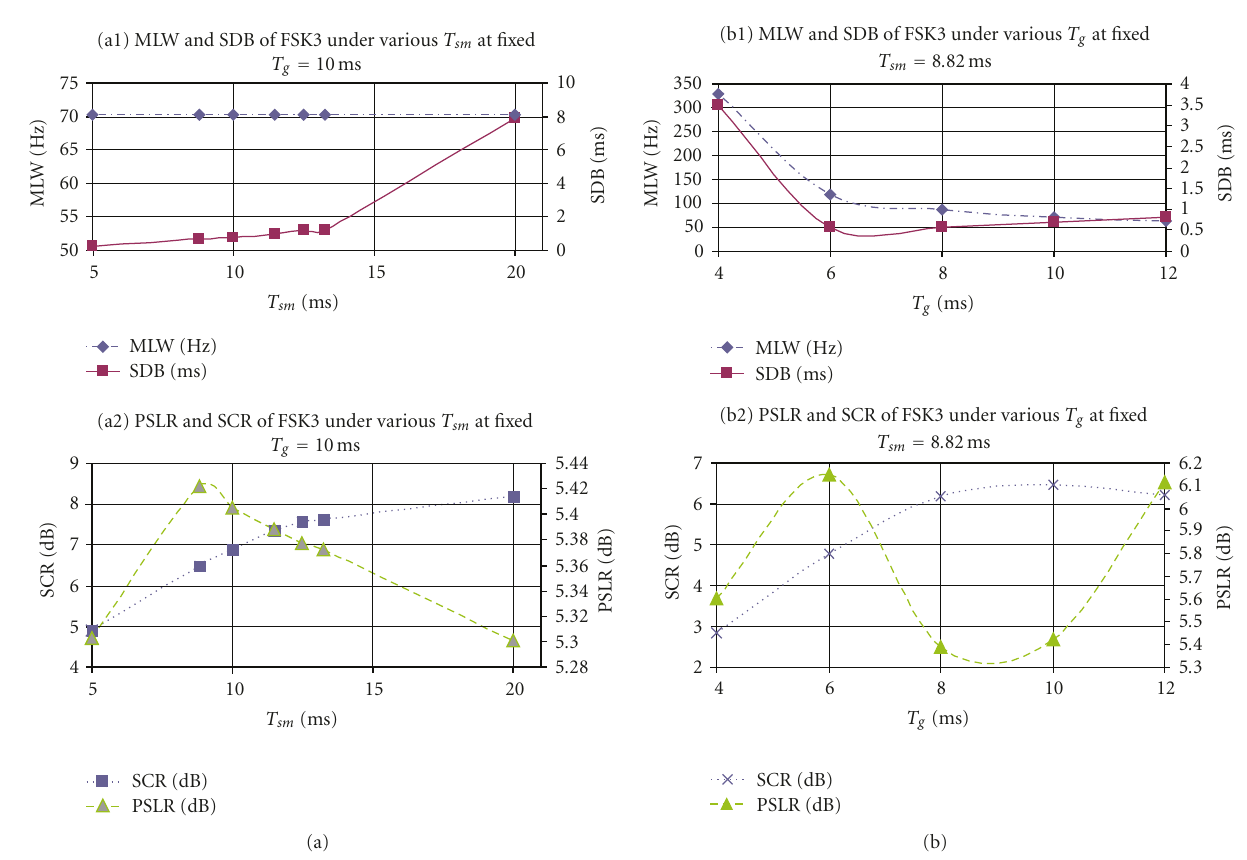
Figure 6: Performance of the TFR of FSK3 using various kernel parameters. (Optimal kernel is the kernel with a small MLW and small SDB but big SCR and big PSLR).